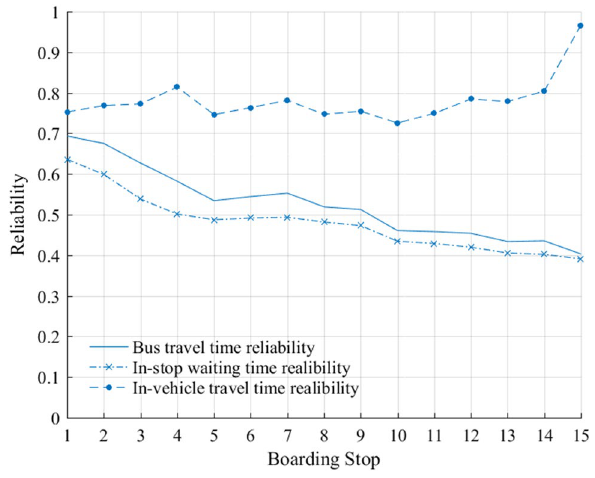
Fig. 12 Bus travel time reliability from different boarding stops to the terminal station Fig. 13 Bus travel time reliabil- ity in different travelers’ arrival